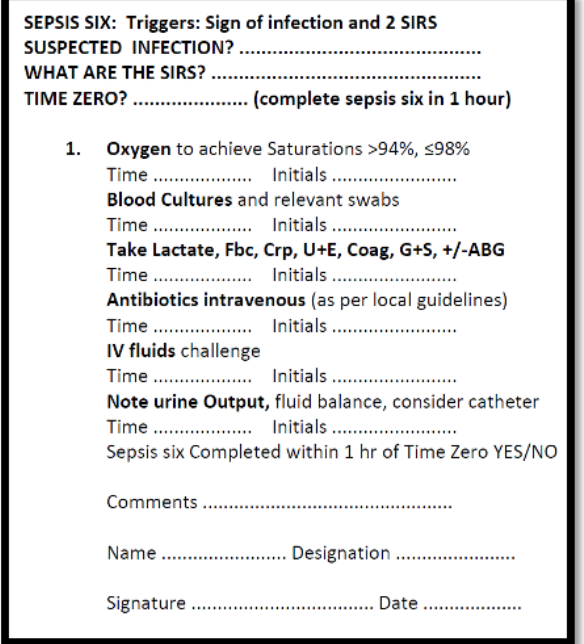
Figure A1. The SSCB sticker that is used in health settings.